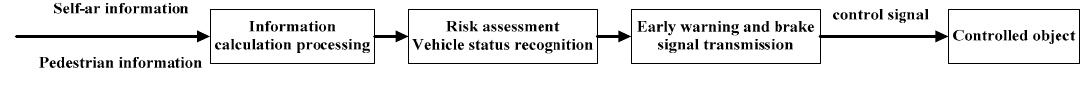
Figure 3. The structure of the AEB-P early warning system.